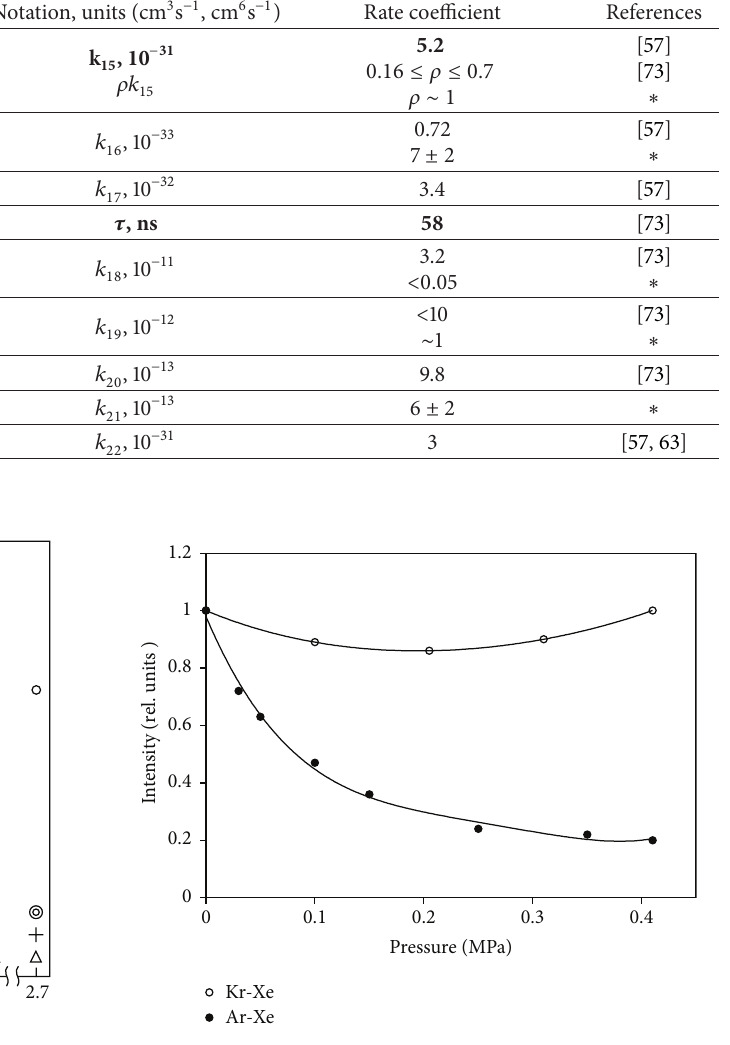
Figure 9: Dependence of the intensity of radiation on the helium pressure in a mixture of Kr(55kPa)-Xe(55 kPa)-He at 𝜆 = 490 nm and in a mixture of Ar(135kPa)-Xe(15kPa)-He at 𝜆 = 329 nm.